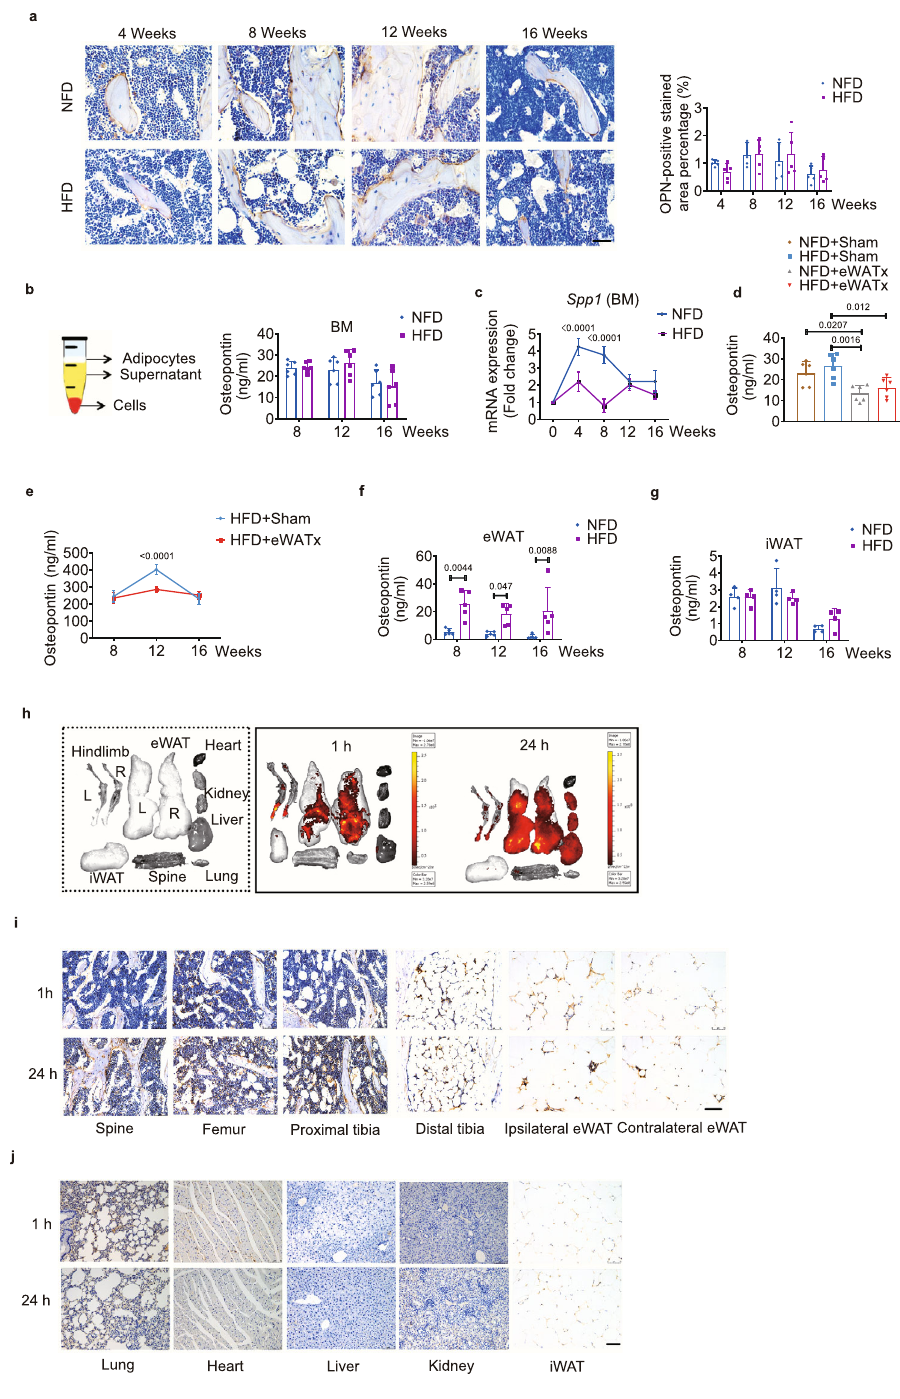
fewer ATMs in fi ltrating eWAT and less accumulation of rBMAT (Fig. 7i – l and Supplementary Fig. 11a). The decreased Trap + osteoclast surface area in the proximal tibiae also contributed to the greater bone mass of HFD-fed mice treated with Neu Ab (Supplementary Fig. 11b, c). Neu Ab did not increase bone mass in the mice fed the NFD, indicating that the bene fi ts of OPN Neu Ab depended on the insult provided by the HFD (Fig. 7i, j). We injected Neu Ab conjugated with FITC into the left-side eWAT of HFD-fed mice. At 1 h or 24 h post-injection, the FITC signal was all near the injection site rather than in other AT depots and organs (Supplementary Fig. 11d), indicating that the Neu Ab injected into unilateral eWAT did not spread in situ. These